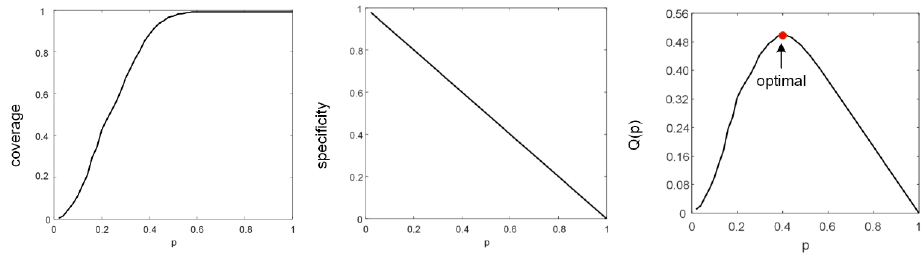
Figure 6. Performance of different granule sizes.